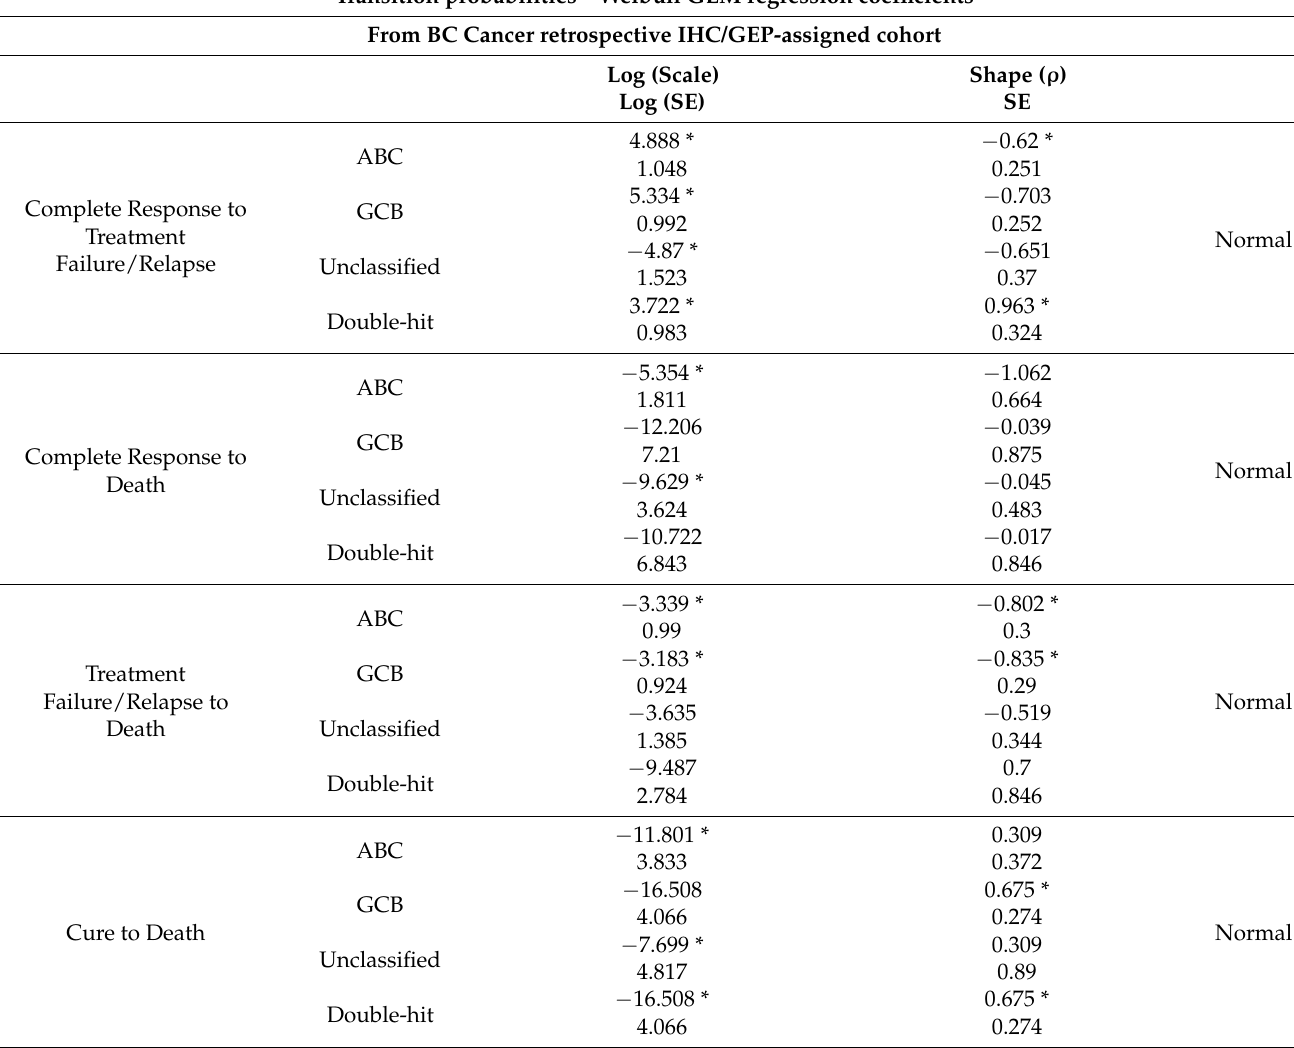
Table 2. Cont. Transition probabilities—Weibull GLM regression